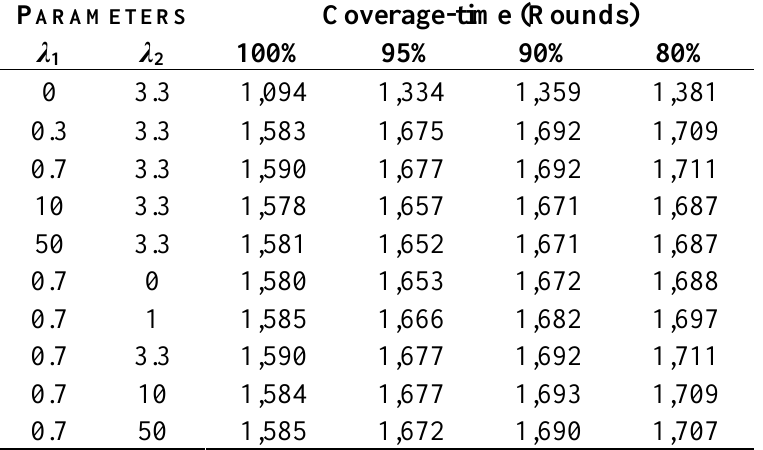
Table 2. Comparison of network lifetimes under different sensing coverage